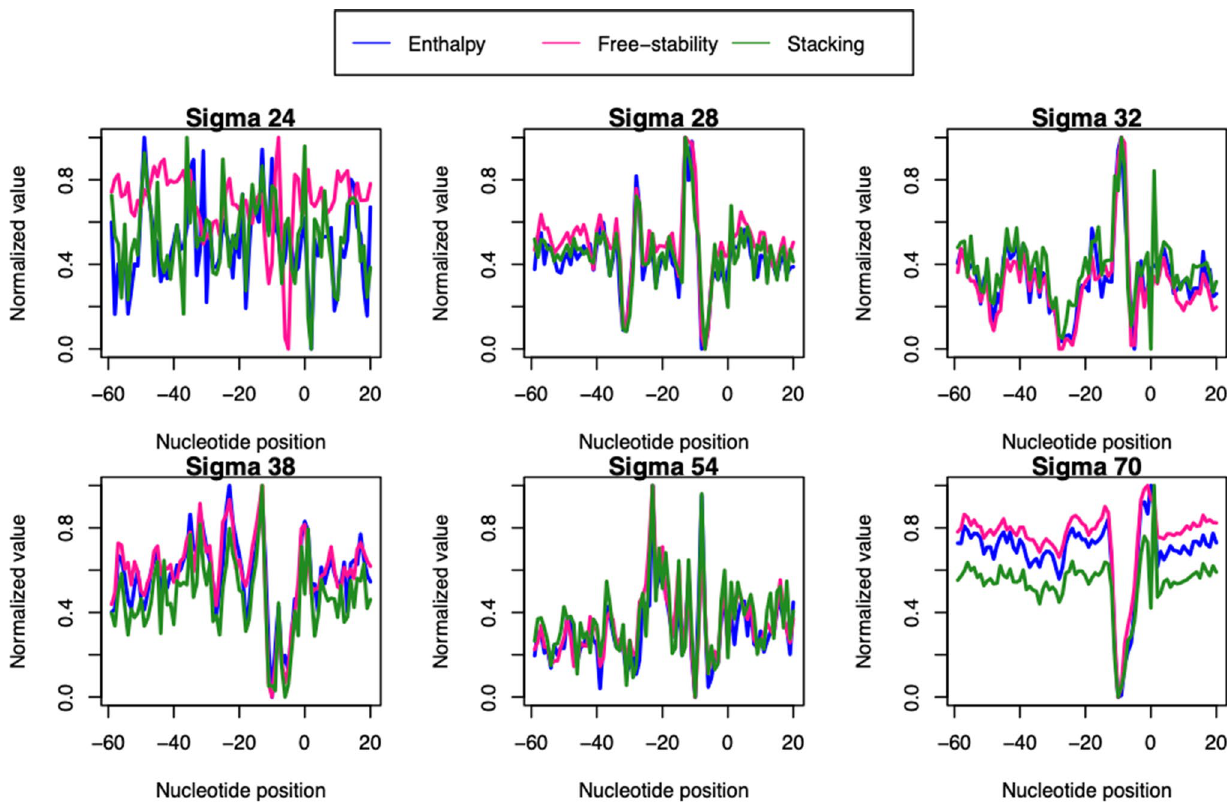
Fig. 1 Averaged values of enthalpy, free-stability, and base-pair stacking along the 80 nucleotides (− 60 to + 20) in E. coli promoter sequences regulated by σ 24 , σ 28 , σ 32 , σ 38 , σ 54 , and σ